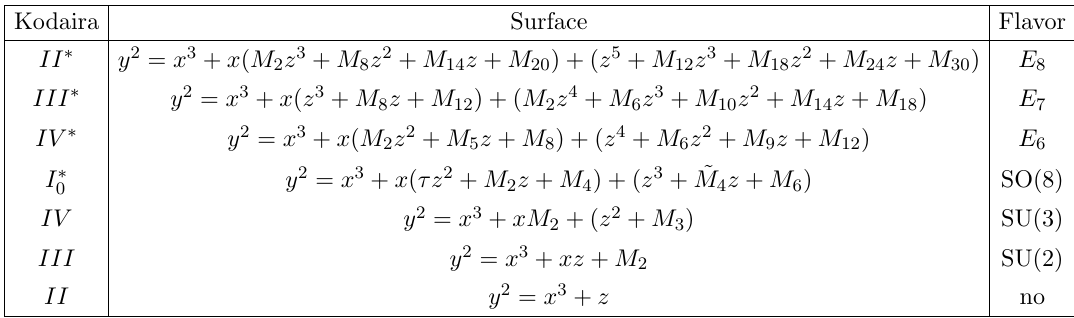
Table 1 . Maximally deformed singularities. M i is the degree- i Casimir invariant of the correspond- ing (cid:13)avor symmetry. ~ M 4 indicates the Pfa(cid:14)an of the so (8) matrix. Table taken from